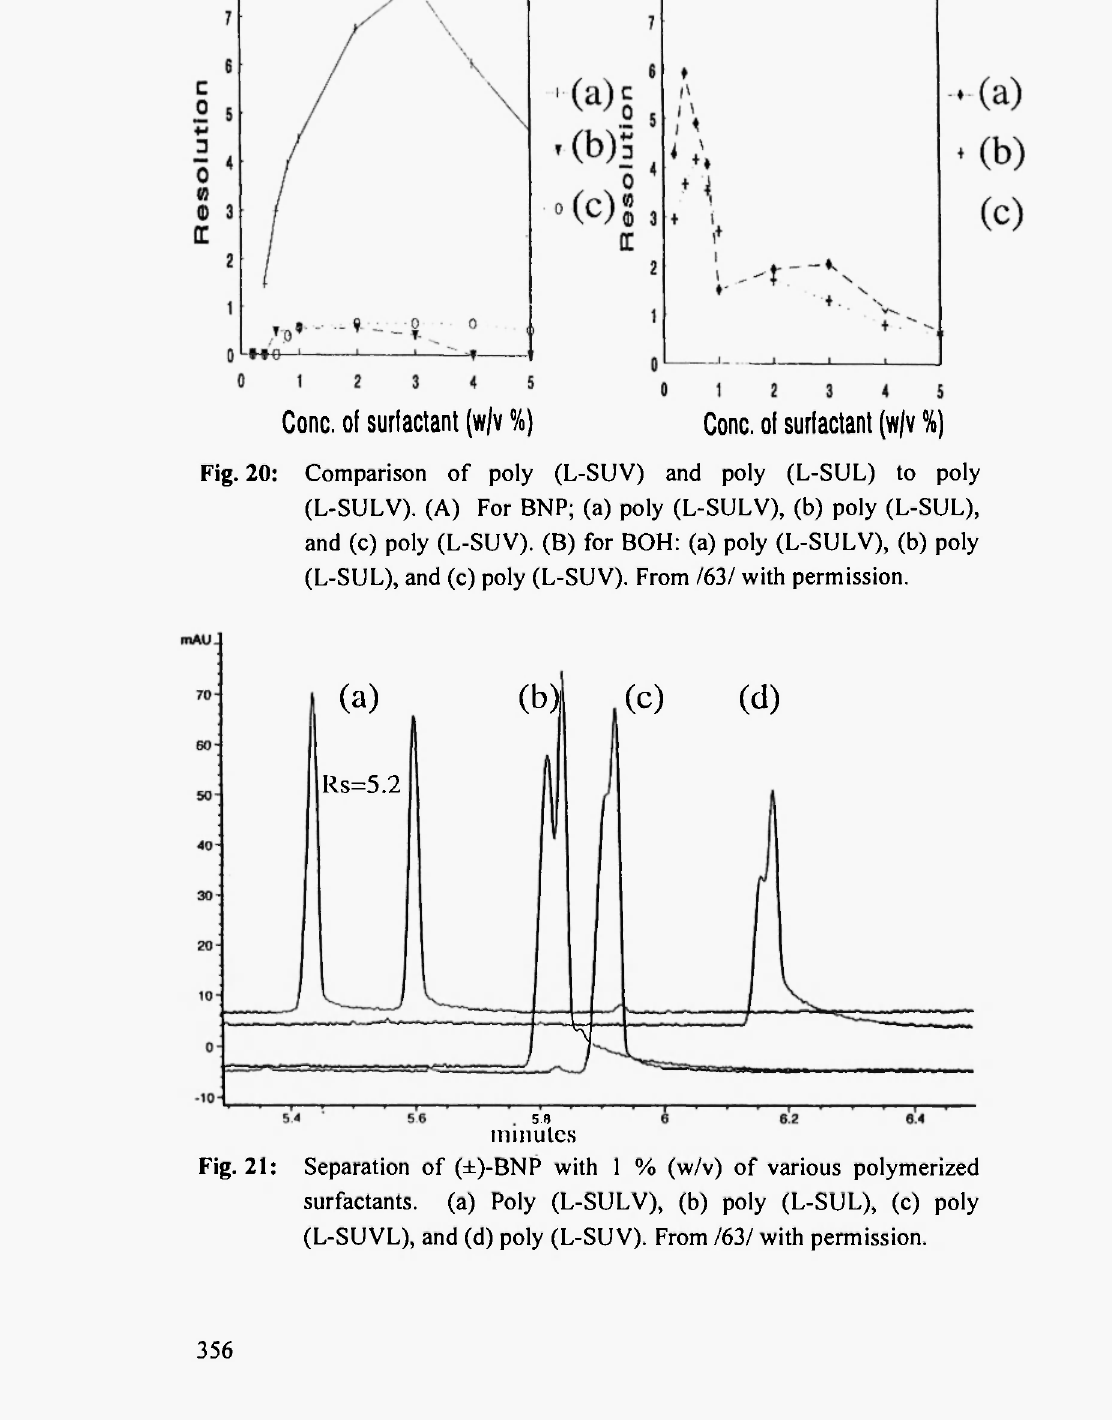
Cone, of surfactant (w/v %) Fig. 20: Comparison of poly (L-SUV) and poly (L-SUL) to poly (L-SULV). (A) For BNP; (a) poly (L-SULV), (b) poly (L-SUL), and (c) poly (L-SUV). (B) for BOH: (a) poly (L-SULV), (b) poly (L-SUL), and (c) poly (L-SUV). From 763/ with permission.